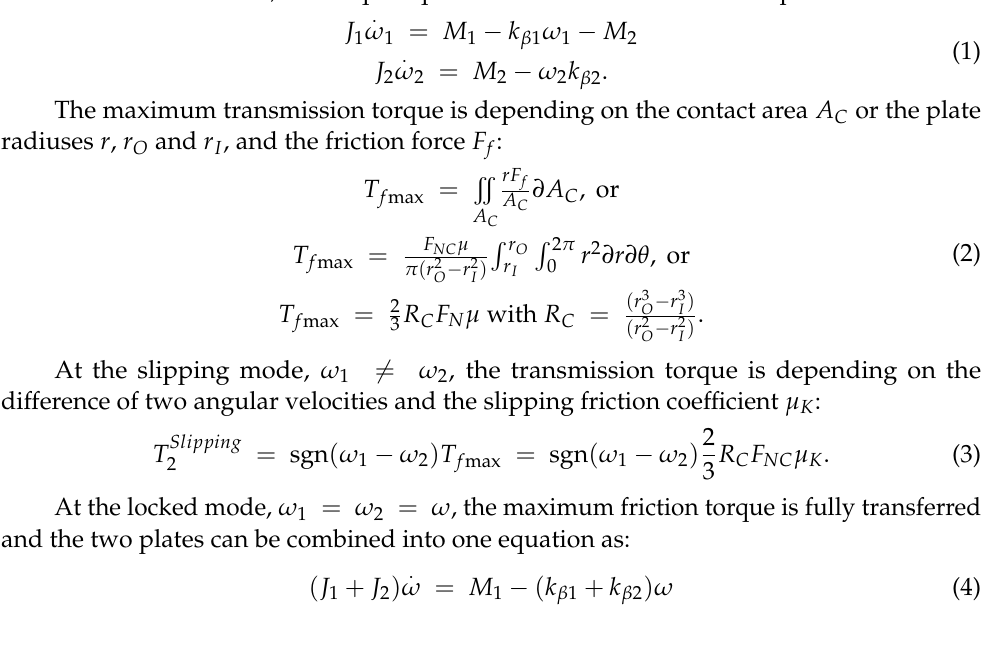
Figure 3. Clutch